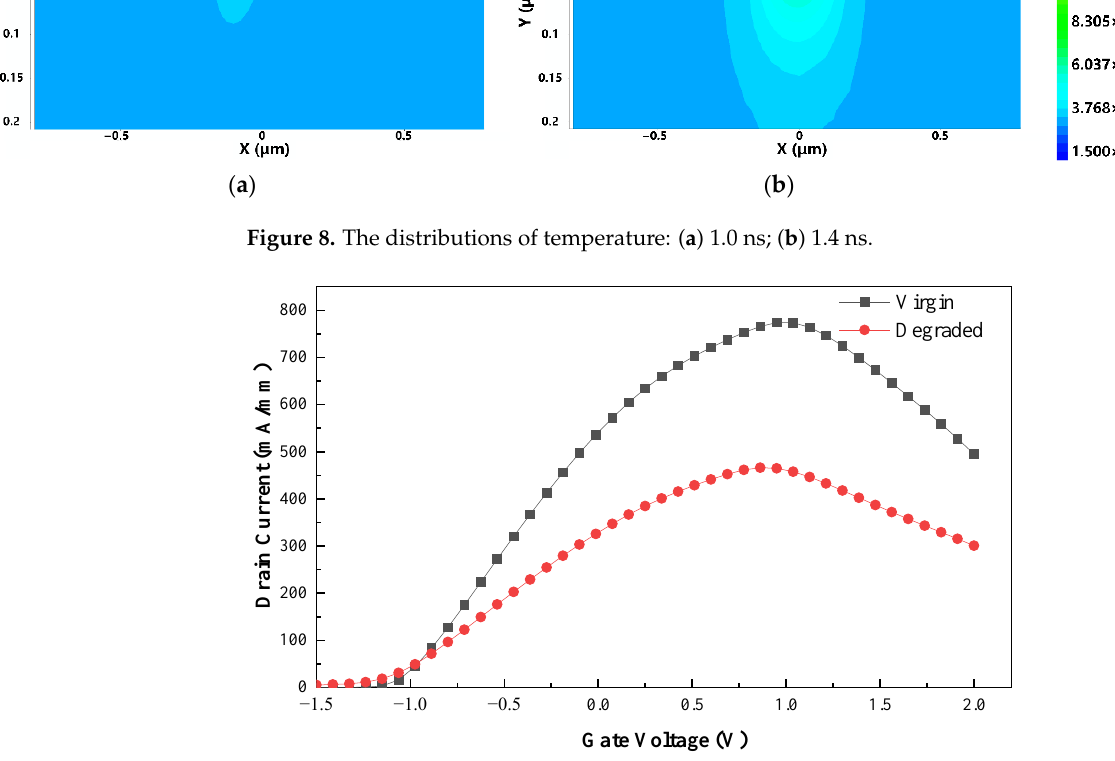
Figure 9. The direct current under UWB pulse jamming.